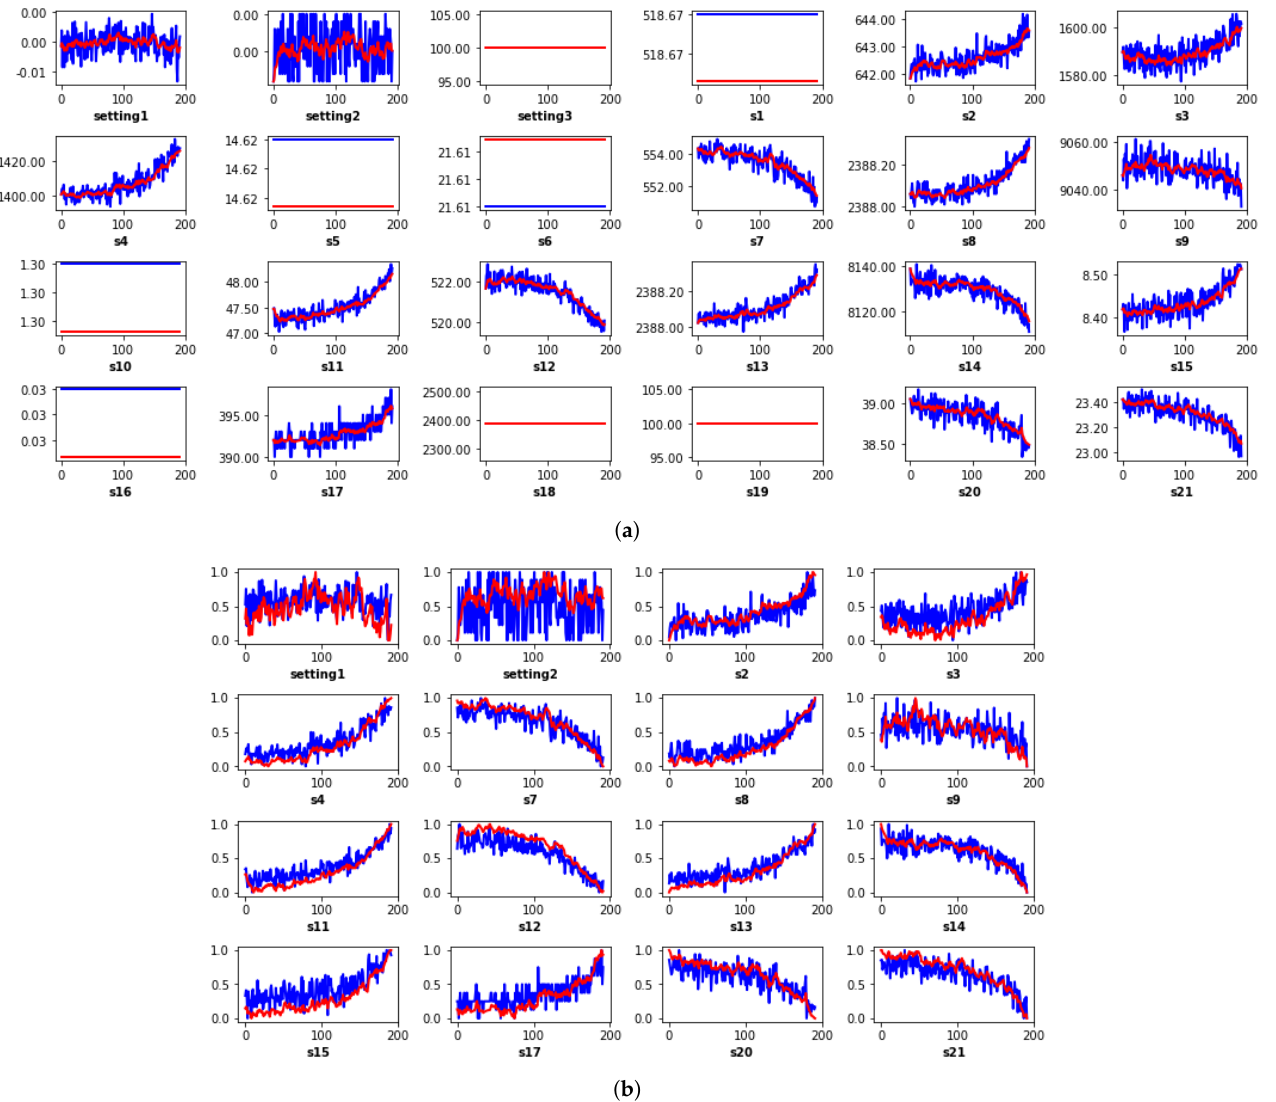
Figure 4. Time series visualization of ( a ) all 24 sensor measurements from the fourth experiment, ( b ) 16 selected sensors with monotonic